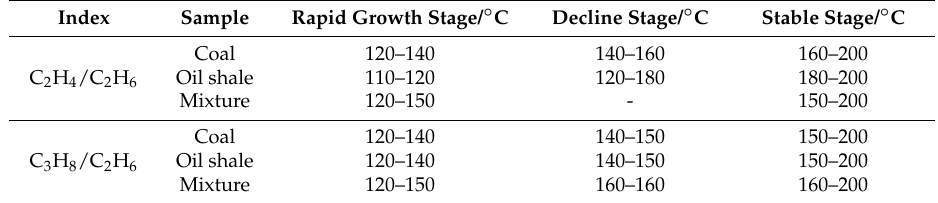
Figure 5. Relationship between the C 2 H 4 /C 2 H 6 ratio and temperature for the experimental samples. Table 5. Three sample stages divided according to the C 2 H 4 /C 2 H 6 andC 3 H 8 /C 2 H 6 ratios.